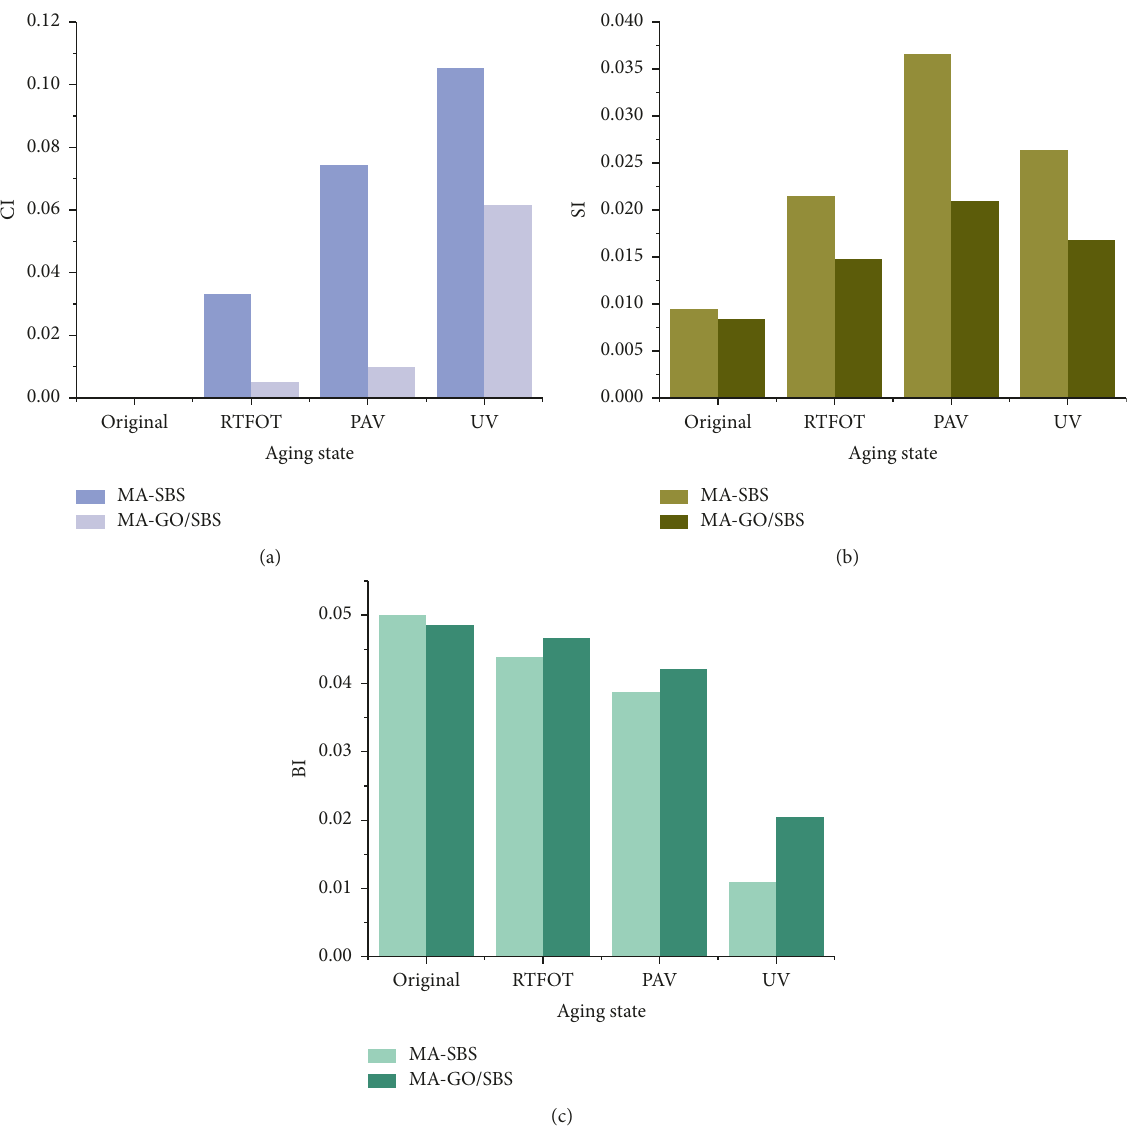
Figure 7: Calculated aging indices: (a) carbonyl index, (b) sulfoxide index, and (c) butadiene index of the modified asphalt binders after different aging